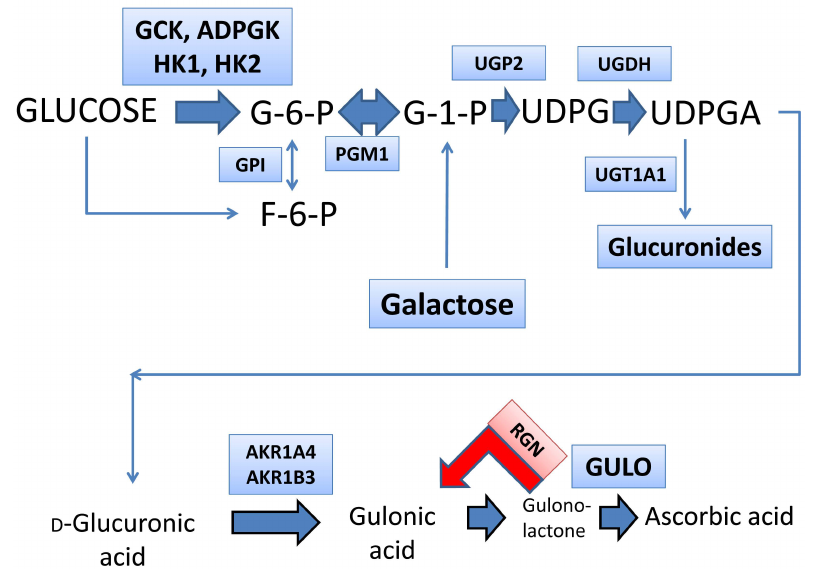
Figure 1. The de novo synthesis of ascorbic acid showing potential enzymes involved whose mRNA expression was determined using quantitative RT-PCR. Intermediates are: G-6-P, glucose 6-phosphate; F-6-P, fructose 6-phosphate; G-1-P, glucose 1-phosphate; UDPG, uridine diphosphate glucose; UDPGA, uridine diphosphate glucuronic acid. The enzymes are: GCK, glucokinase (HK4; EC 2.7.1.1); ADPGK, ADP-dependent glucokinase (EC 2.7.1.147); HK1, hexokinase 1 (EC 2.7.1.1); HK2, hexokinase 2 (EC 2.7.1.1); GPI, glucose 6-phosphate isomerase (EC 5.3.1.9); PGM1, phospho- glucomutase 1 (EC 5.4.2.2); UGP2, UDP-glucose pyrophosphorylase 2 (EC 2.7.7.9); UGDH, UDP glucose 6-dehydrogenase (EC 1.1.1.22); UGT1A1, UDP glucuronosyltransferase family 1 member A1 (EC 2.4.1.17); AKR1A4, aldo-keto reductase family 1, member A1 (aldehyde reductase; EC 1.1.1.2); AKR1B3, aldo-keto reductase family 1, member B3 (aldose reductase; EC 1.1.1.21); RGN, regucalcin (gluconolactonase; EC 3.1.1.17); and GULO, gulonolactone oxidase (EC